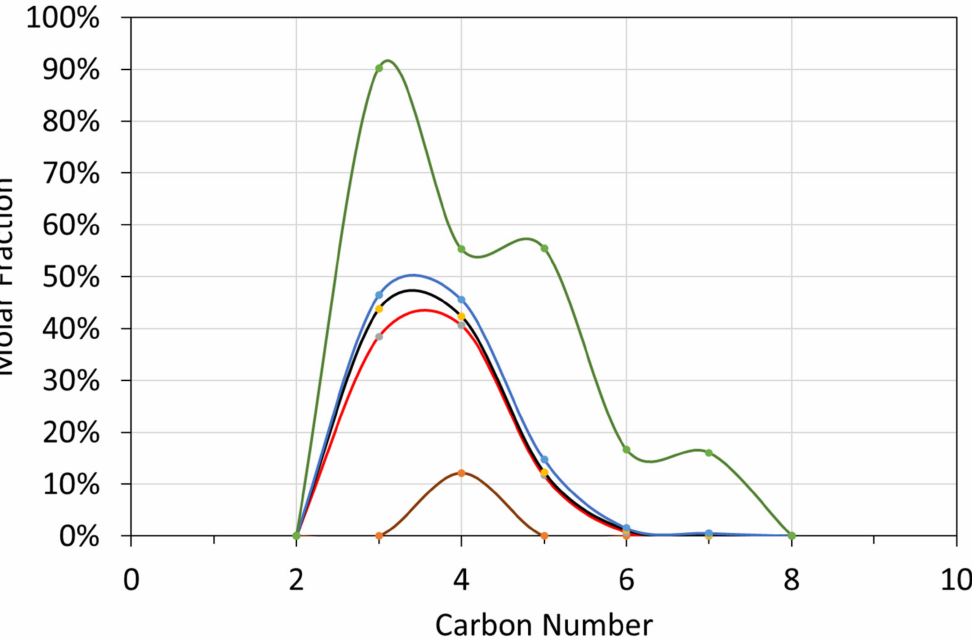
Figure A1. Molar Gas Composition Probability Distribution as a function of carbon number: T ≤ 298 K; brown line = minimum value (0%); red line = first quartile value (25%); black line = median value (50%); blue line = third quartile value (75%); green line = maximum value (100%). A value of 75% means that there is a 75% probability, that the molar fraction of the specific carbon species, will have a lower value.